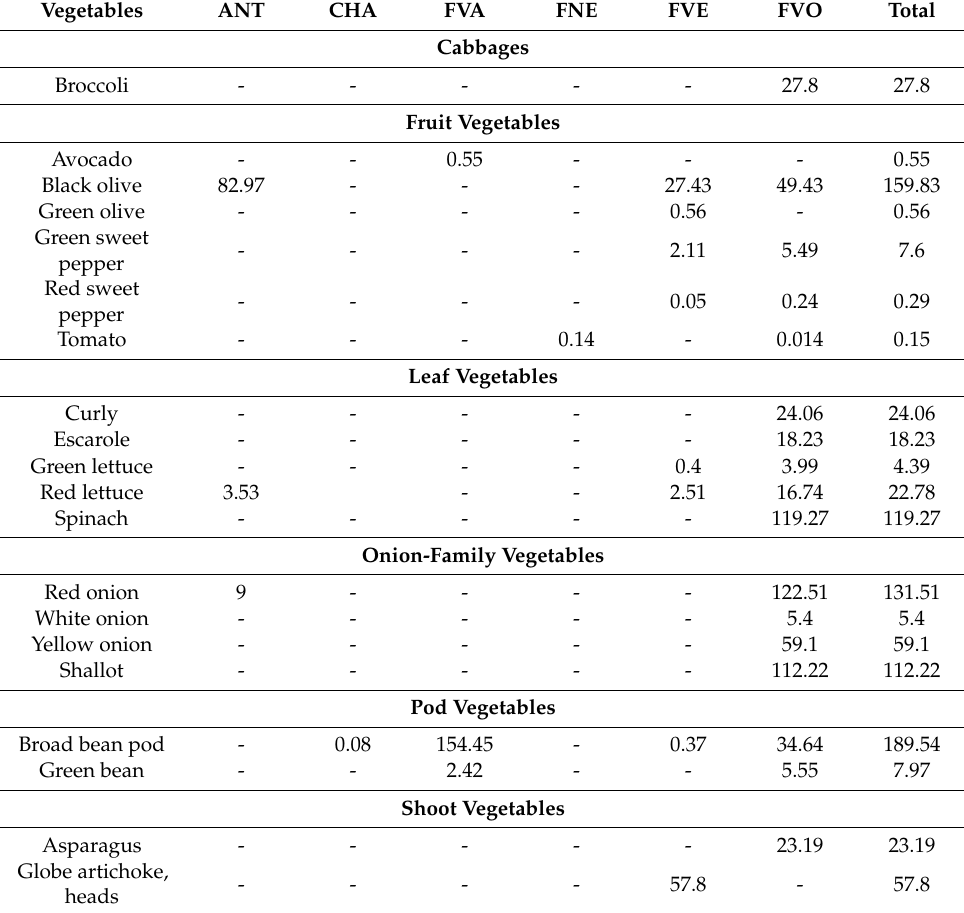
Table 2. Flavonoid contents of vegetables (mg / 100 g food)